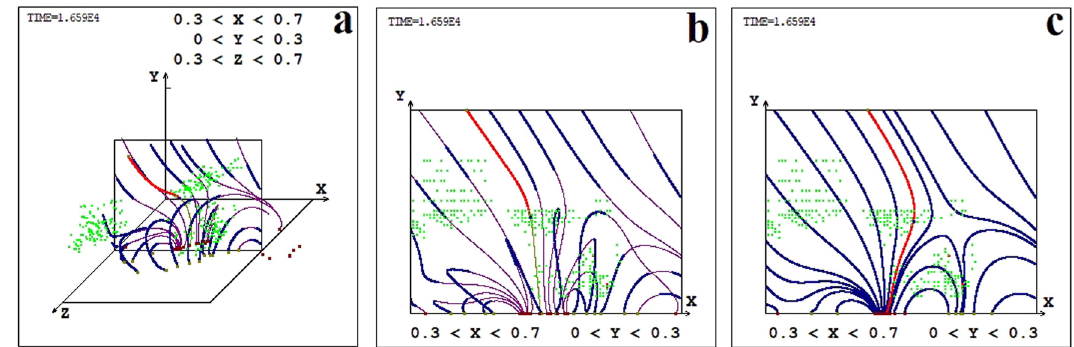
Figure 4: The results of MHD modeling and their comparison with observational data with the NoRH at the time 05/26/2003 01:00 ( time from the beginning of the calculation is 1.1728 days, × 1.659 10 4 in dimensionless units ) . The positions of the current density maxima are shown in green. ( a ) Three - dimensional con fi guration of the magnetic fi eld in the region (